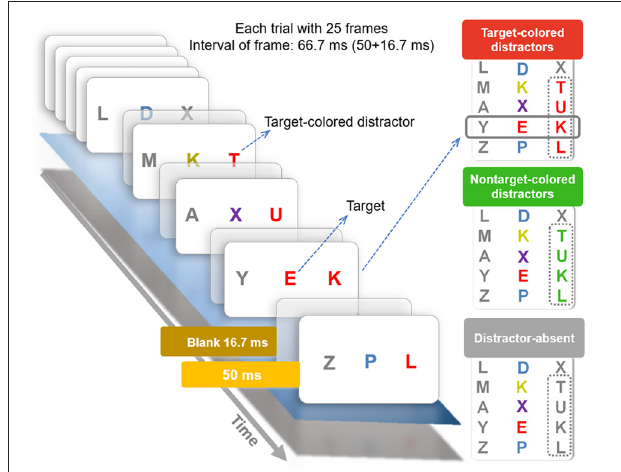
FIGURE 2 | The rapid serial visual presentation (RSVP) task conditions and time-line. The left part of the figure shows the time-line of a typical trial. Each new letter was presented for 50 ms and followed by a 16.7 ms blank screen, such that letters appeared every 67 ms. The right part shows the three different trial type/conditions used in the task which were: (1) distractor-absent: the distractor stream was of just gray letters; (2) target-colored distractor: one peripheral stream contained red distractor letters which started two letters before the onset of the target in the central stream and continued until one letter after the target, making four letters in total; and (3) non-target-colored distractor: this was the same as the target-colored distractor condition except the peripheral distractor was